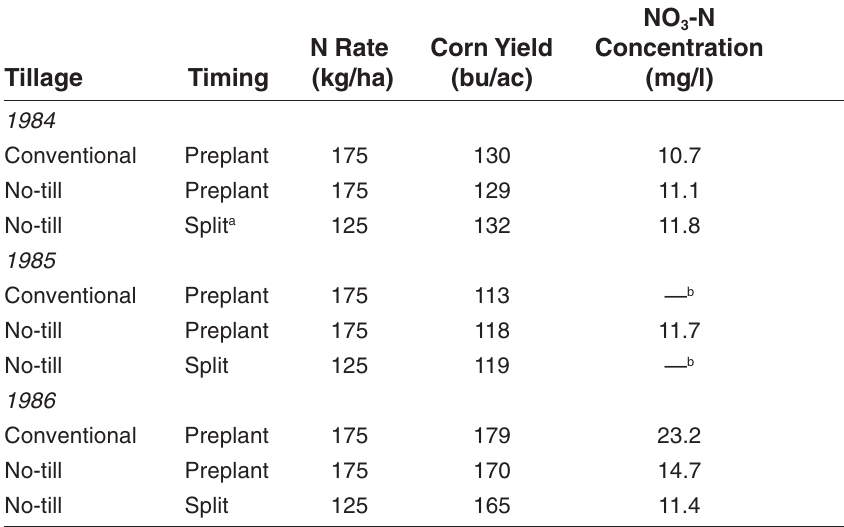
Corn Yields and NO -N Concentrations in Tile Drainage as 3 Affected by Tillage and Rate/Timing of N Application (1984–1986)